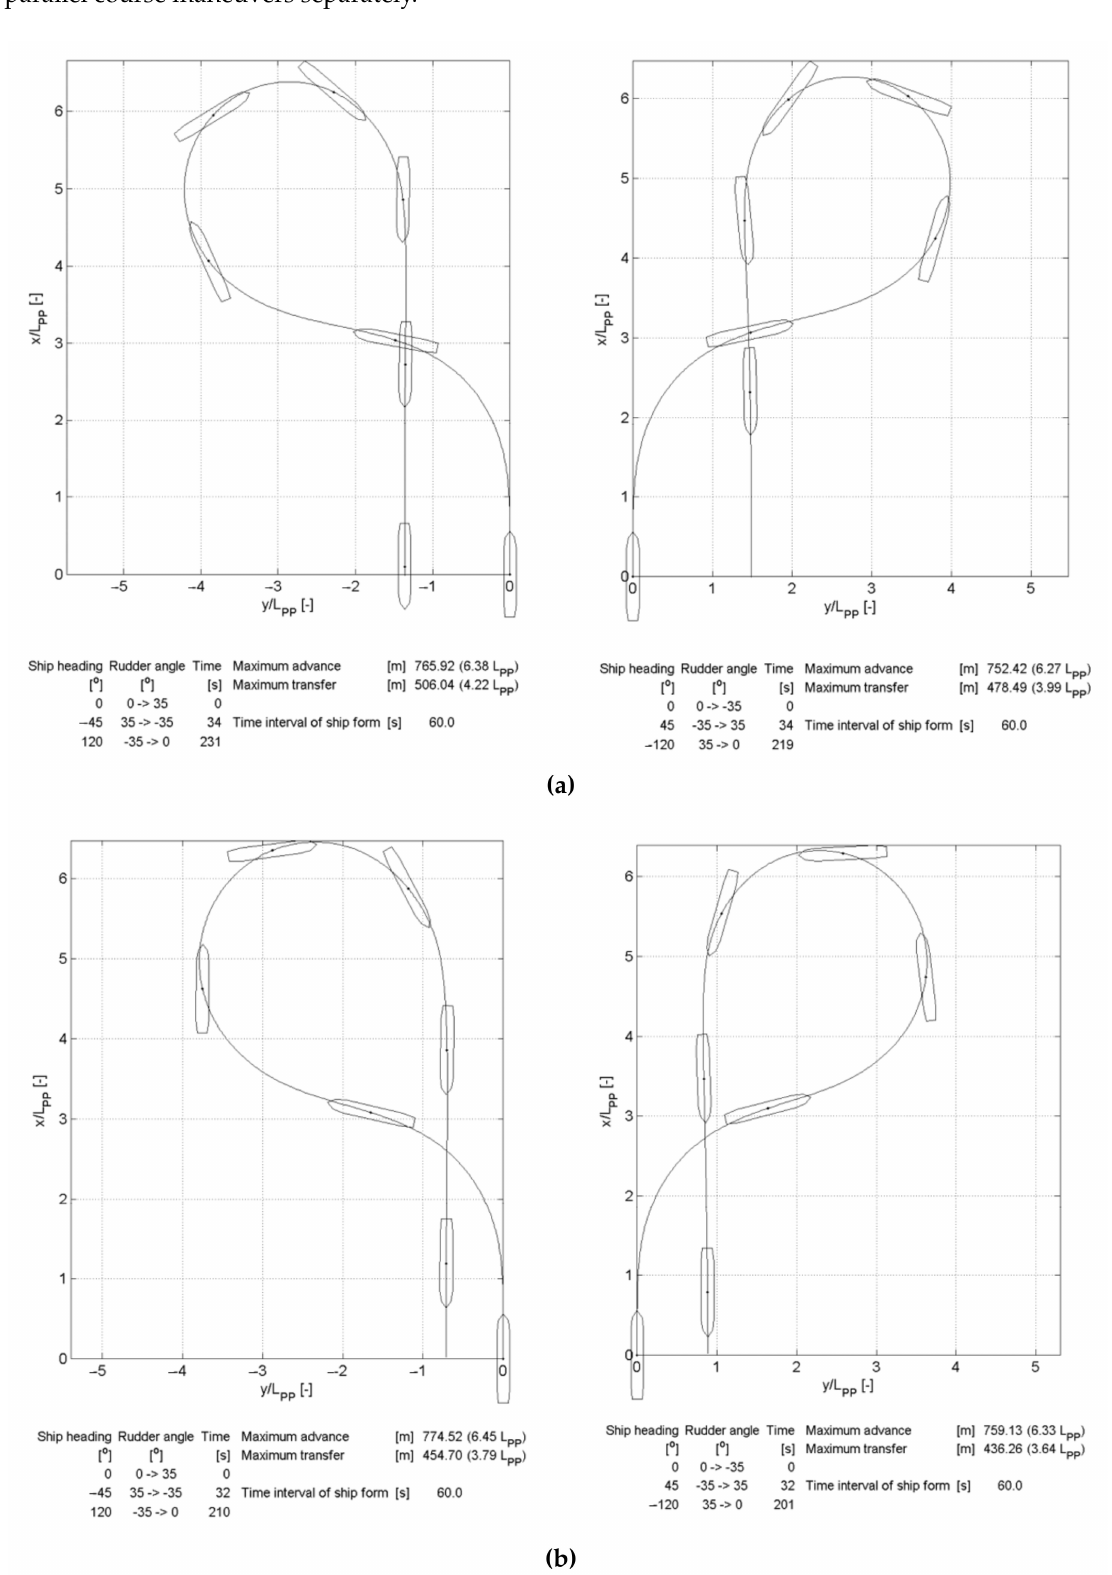
Figure 14. Williamson turning test of T / S Segero: ( a ) Full load condition; and ( b ) Ballast